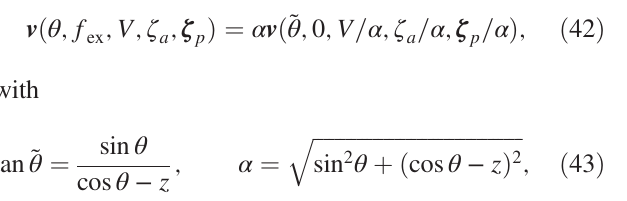
FIG. 5. Output power (solid curves) and active efficiency (dashed curves) as a function of the external force f velocity filter (black curves), chevron (red curves), and kite (orange curves) from Fig. 4 for a single active particle. The ratio of mobilities is kept fixed at μ p = μ a ¼ 0 . 1